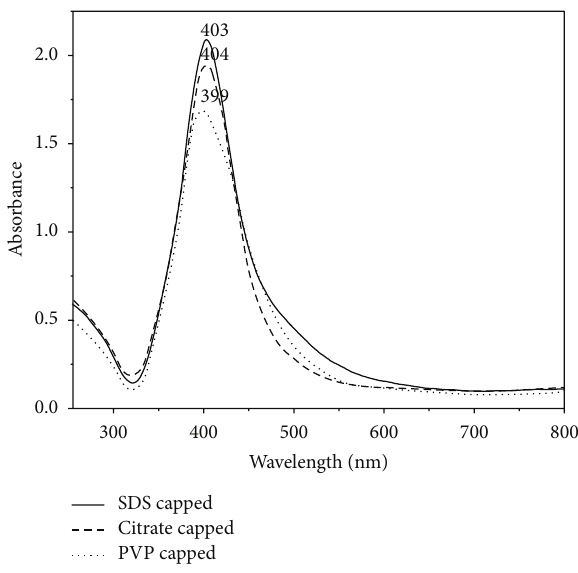
Figure 1: The UV-Vis absorption spectra of capped silver nanopar- ticles synthesized with sodium